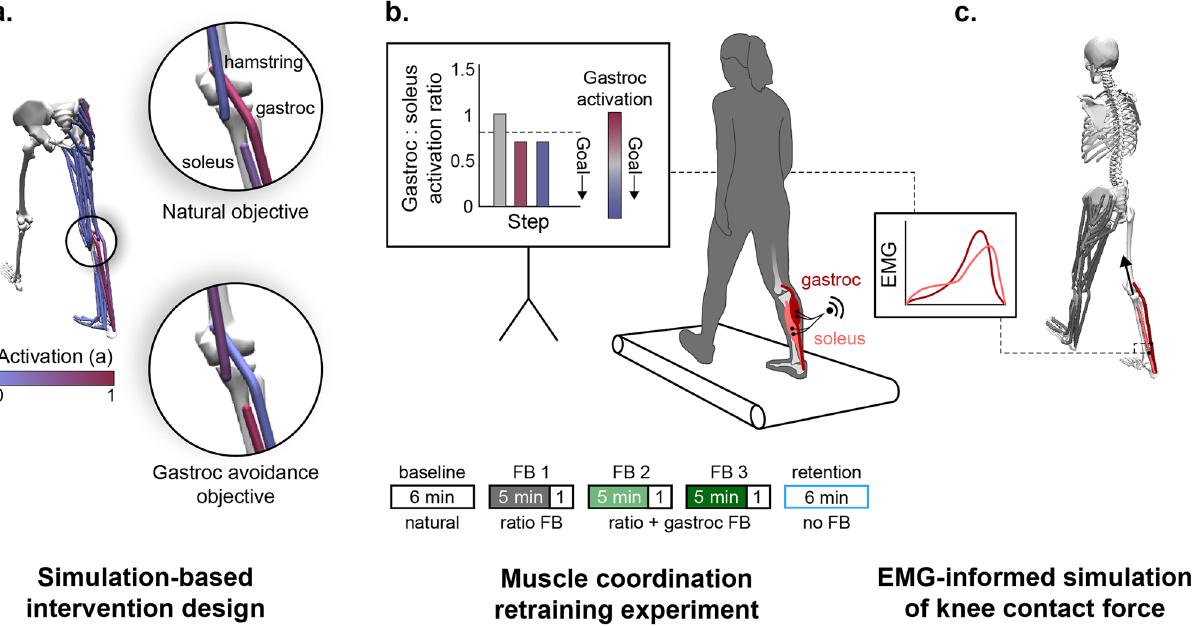
Figure 2. Simulation-inspired biofeedback design process. ( a ) To design the biofeedback for teaching individuals to walk without activating their gastrocnemius (gastroc), we simulated walking using both a natural and a gastrocnemius avoidance objective function (Eqs. 1 and 2) in the static optimization muscle redundancy solver. ( b ) Based on the simulation results, we provided individuals with visual biofeedback of their muscle activation, measured with electromyography (EMG), that instructed them to change the coordination of their ankle plantarflexor muscles. Participants performed five walking trials: a baseline trial (natural walking), three trials with visual biofeedback, and a retention trial without feedback. During all three feedback (FB) trials, visual biofeedback instructed participants to reduce their gastrocnemius-to-soleus activation ratio (bar magnitude). During the final two feedback sessions, additional feedback was provided, instructing participants to also reduce their average gastrocnemius (gastroc) activity (bar color). ( c ) EMG-informed static optimization simulations were used to assess the effect of a gastrocnemius avoidance coordination pattern on knee contact force. The simulated gastrocnemius-to-soleus activation ratio was constrained to match the ratio measured with